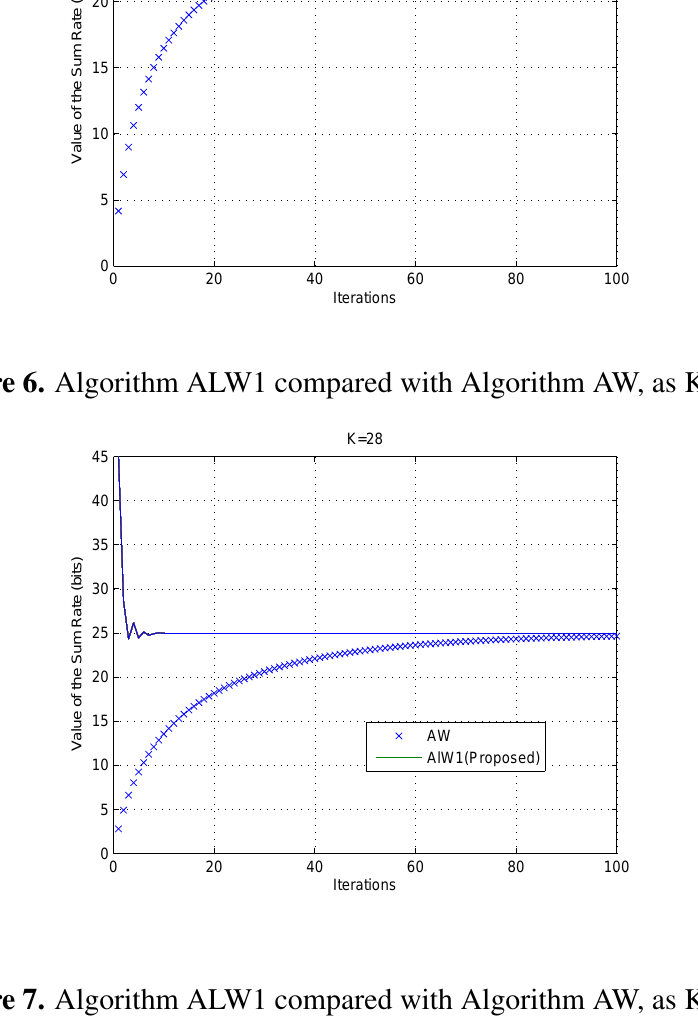
Figure 7. Algorithm ALW1 compared with Algorithm AW, as K =